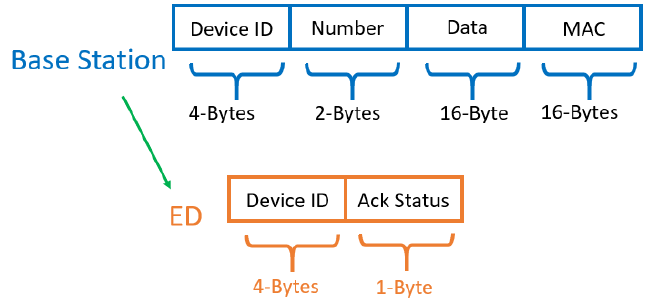
Table 4. The energy consumed doing a firmware update at each Long Range (LoRa) setting. Setting Start OCV Stop OCV